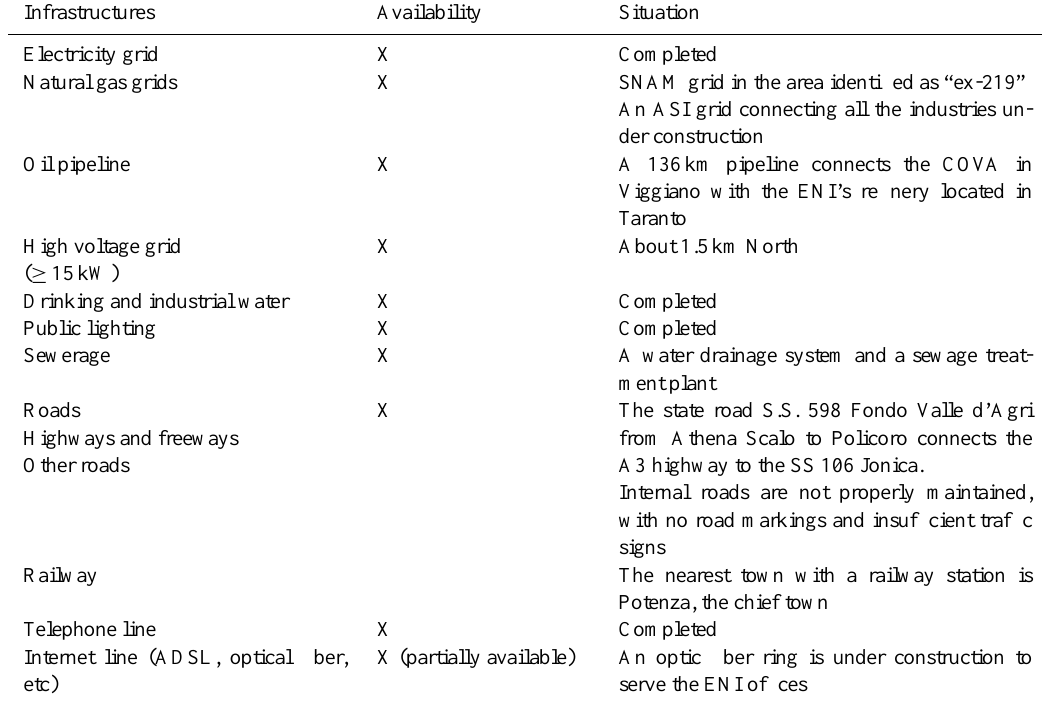
Table 2. State of infrastructures of Alta Val d’Agri industrial